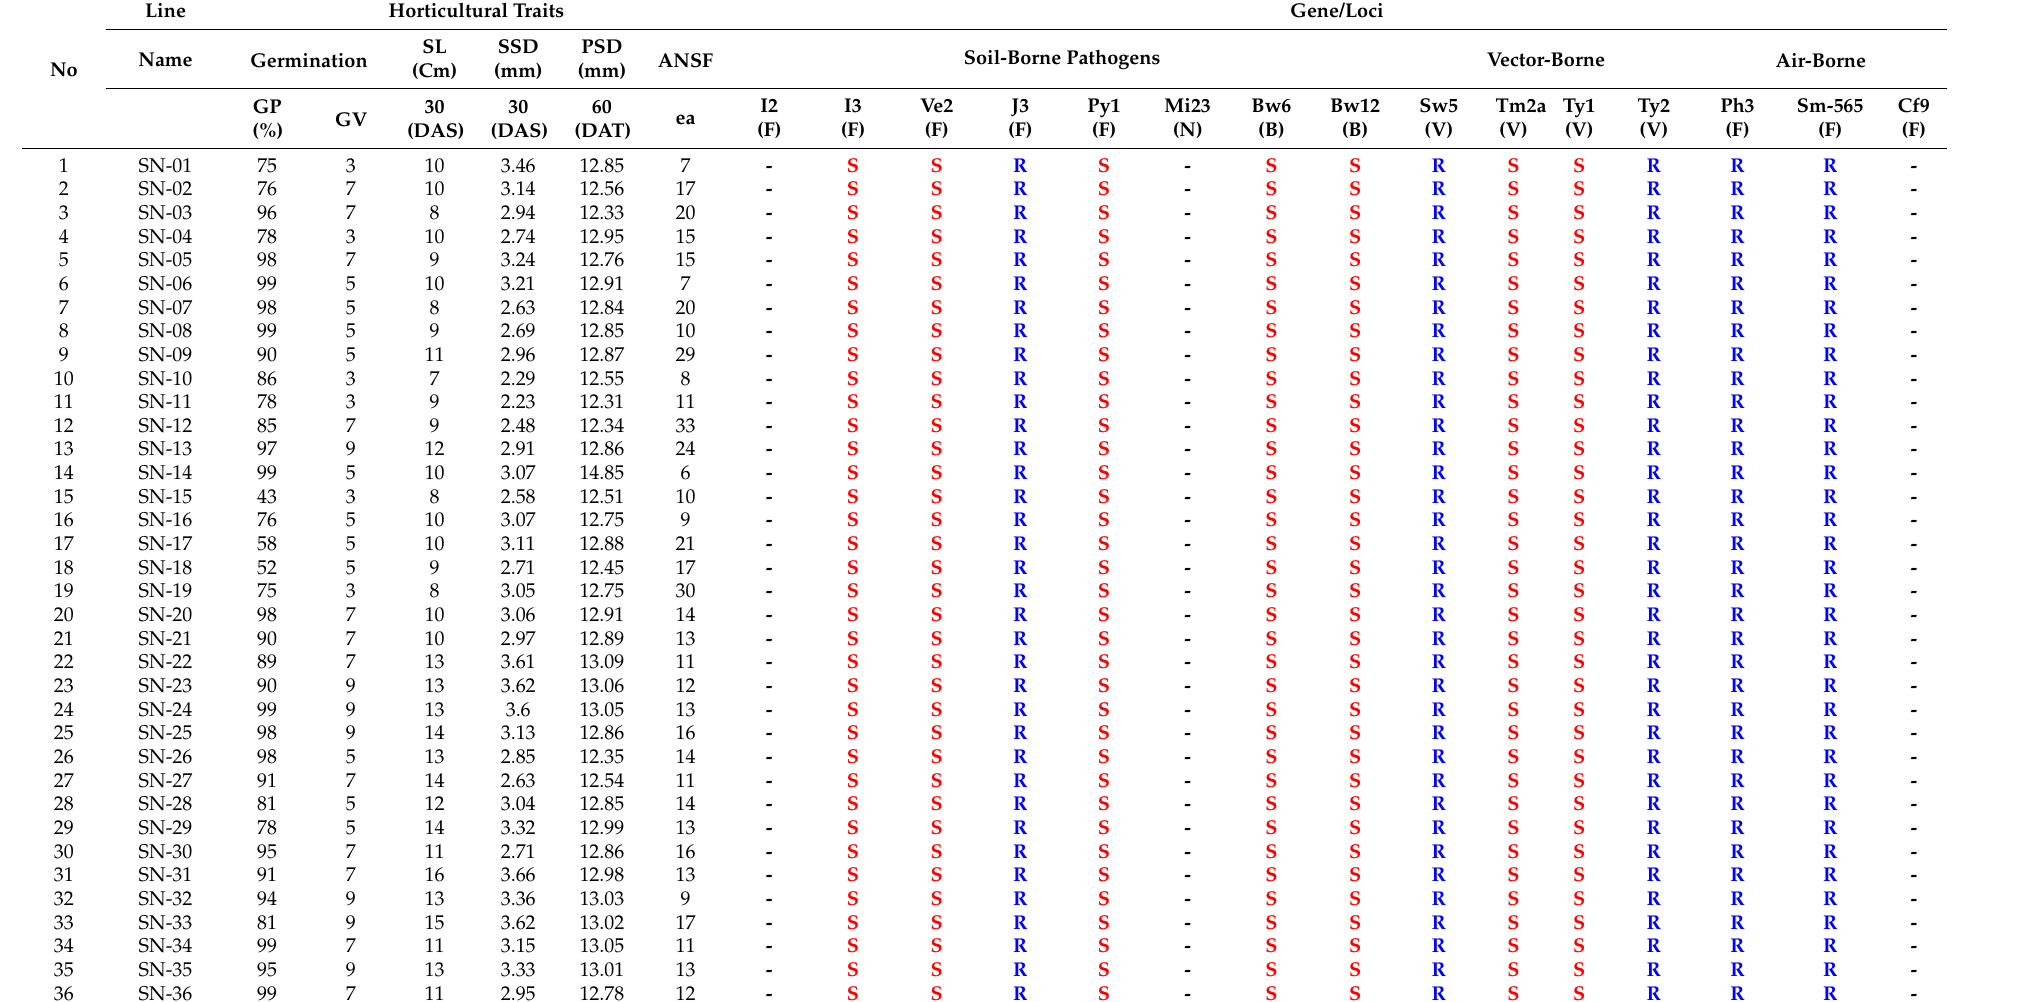
Table 2. Lists horticultural traits and Gene/Loci of Solanum habrochaites